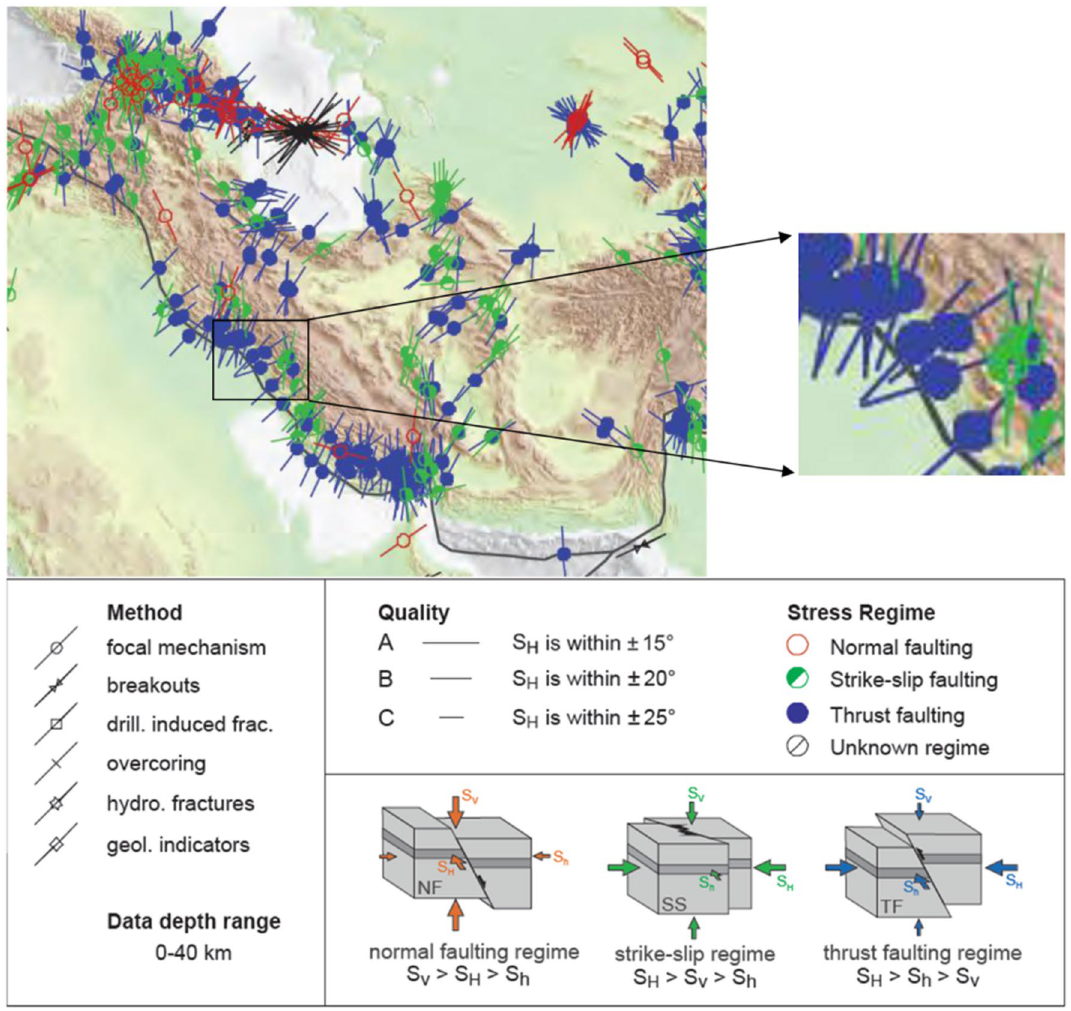
Fig. 1 Stress distribution map for Iran (general azimuth of S